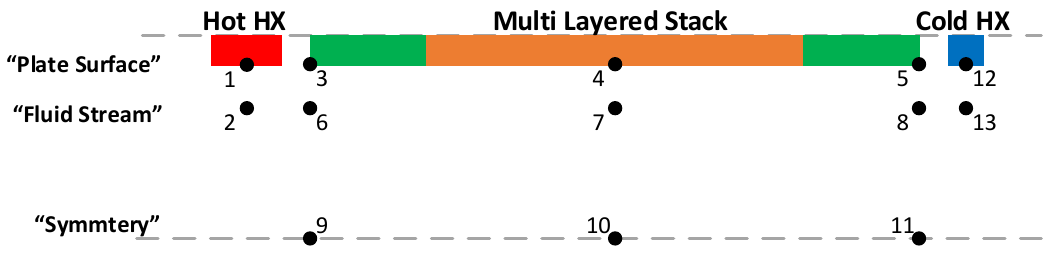
Figure 4. Monitor points for evaluation of results.